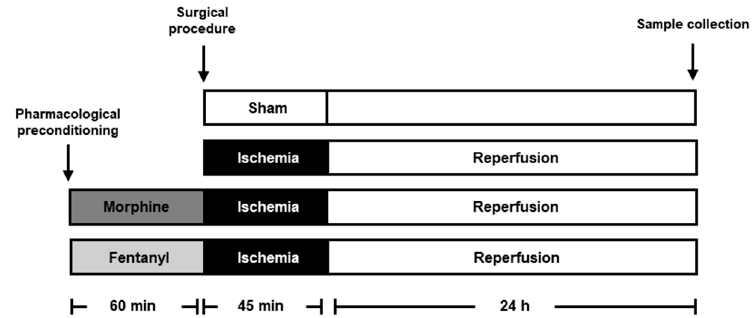
Figure 1. Experimental scheme. Graph illustrating experimental conditions in the study. Six male Wistar rats were treated with 0.5 mg/kg morphine (dark gray bar) or 10 µg/kg fentanyl (light gray bar) for 60 min before the left renal pedicle was occluded for 45 min to promote ischemia and a 24 h reperfusion period. As controls we performed a sham group (white bar) and ischemia-reperfusion injury (IRI) without preconditioning (black bar). The gray scale identification is preserved in all figures. Blood and kidney tissue samples were collected at the end of the reperfusion period.